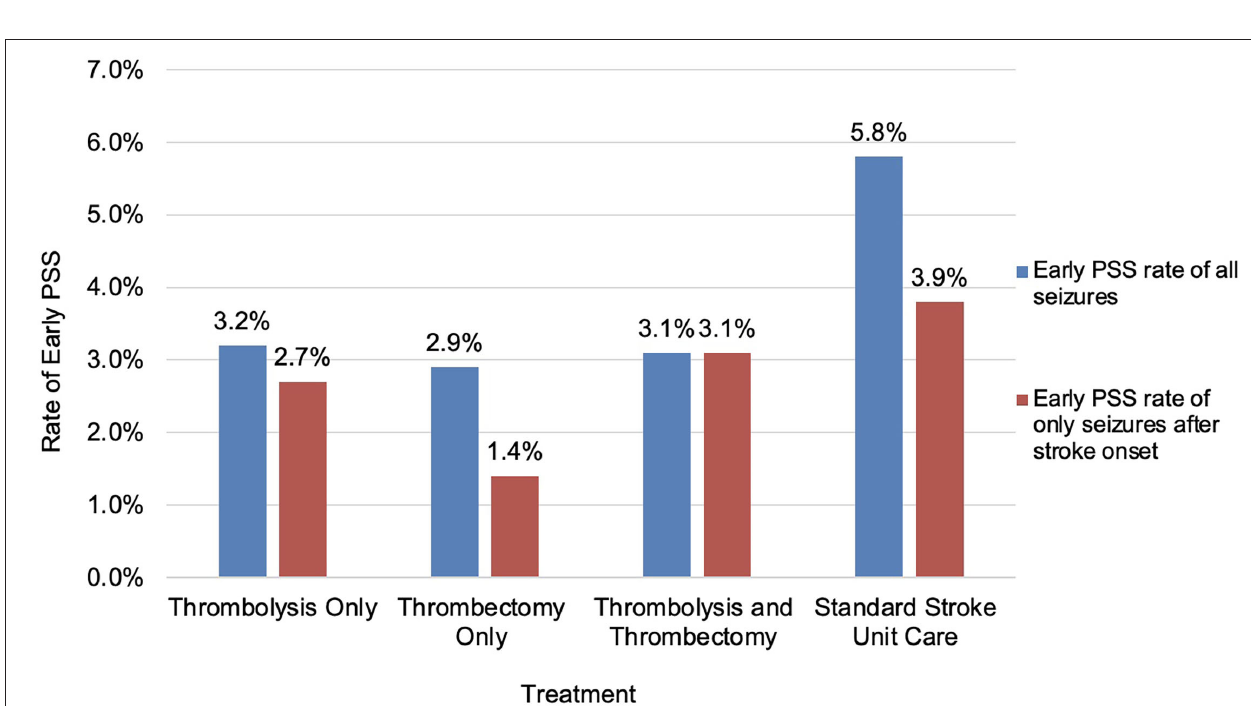
thereby increasing the ability to induce a hyperexcited neuronal state (22, 24). Studies also show that mice with overexpression of